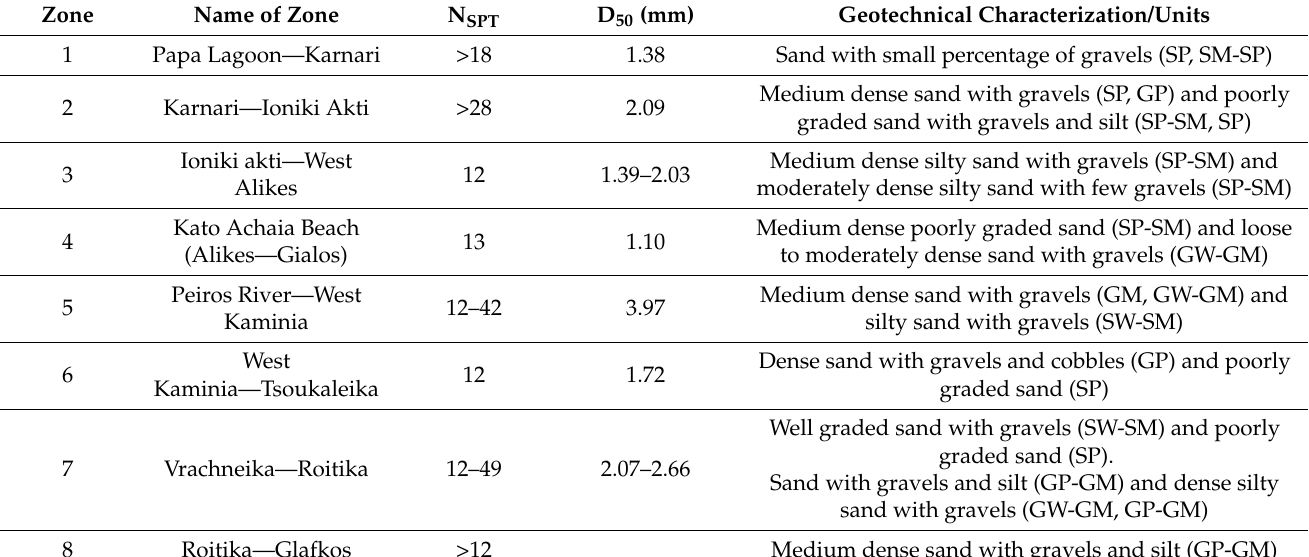
Table 1. Geotechnical characterization of the eight (8) zones existing in the Pilot area (N SPT : Number of SPT blow counts and D 50 : average grain